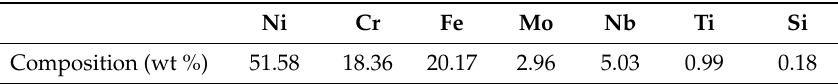
Table 1. The chemical composition of the material.